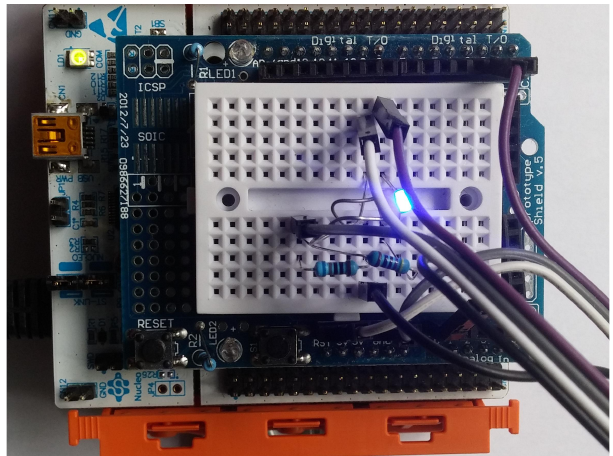
Figure 6. Image of a nucleo-f401 board with an extension shield that is used in our